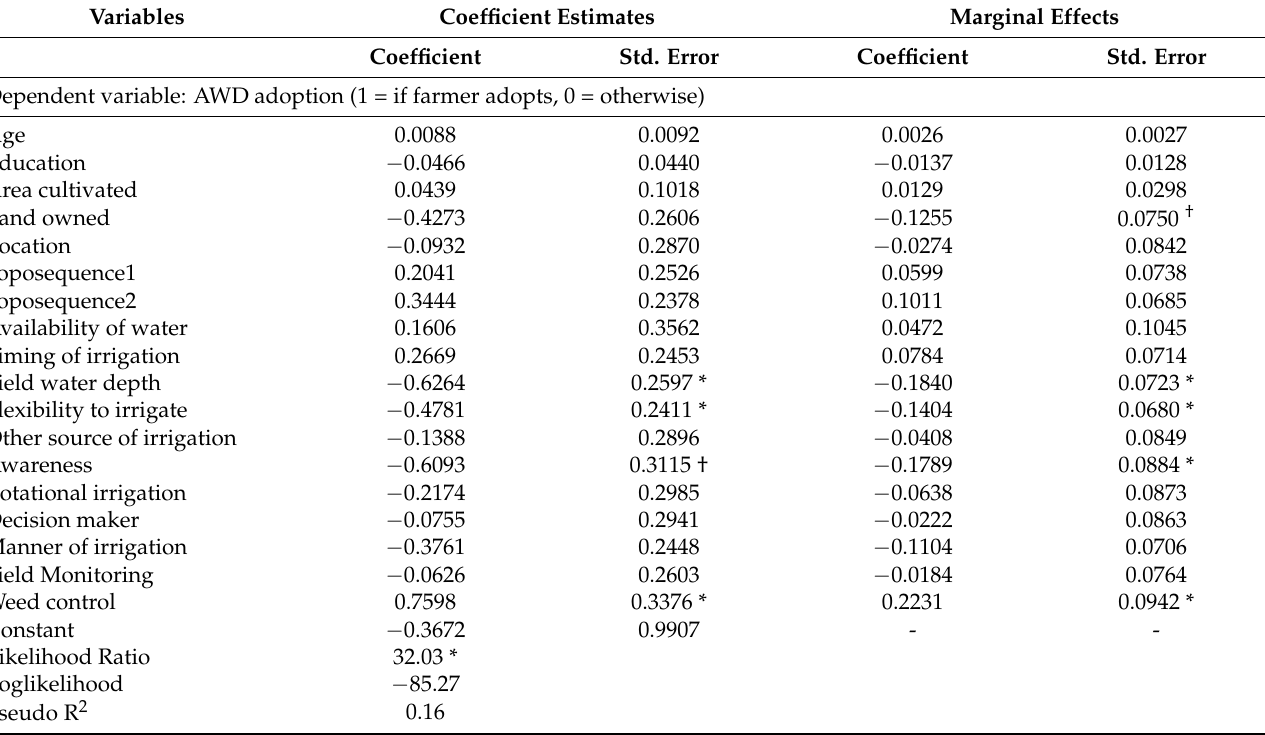
Table 4. Determinants in the adoption of